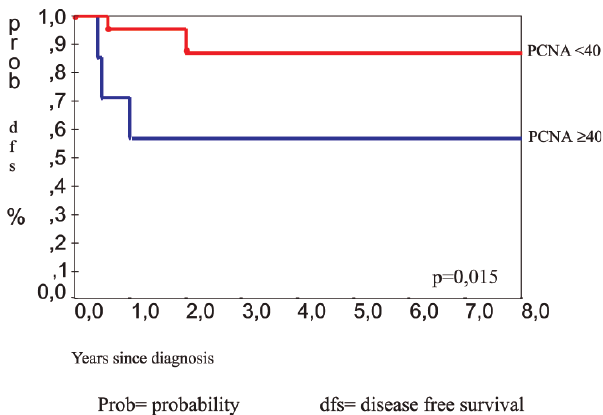
Figure 13 - Kaplan-Meier test for event recurrence, comparing PCNA labeling index ³40 and <